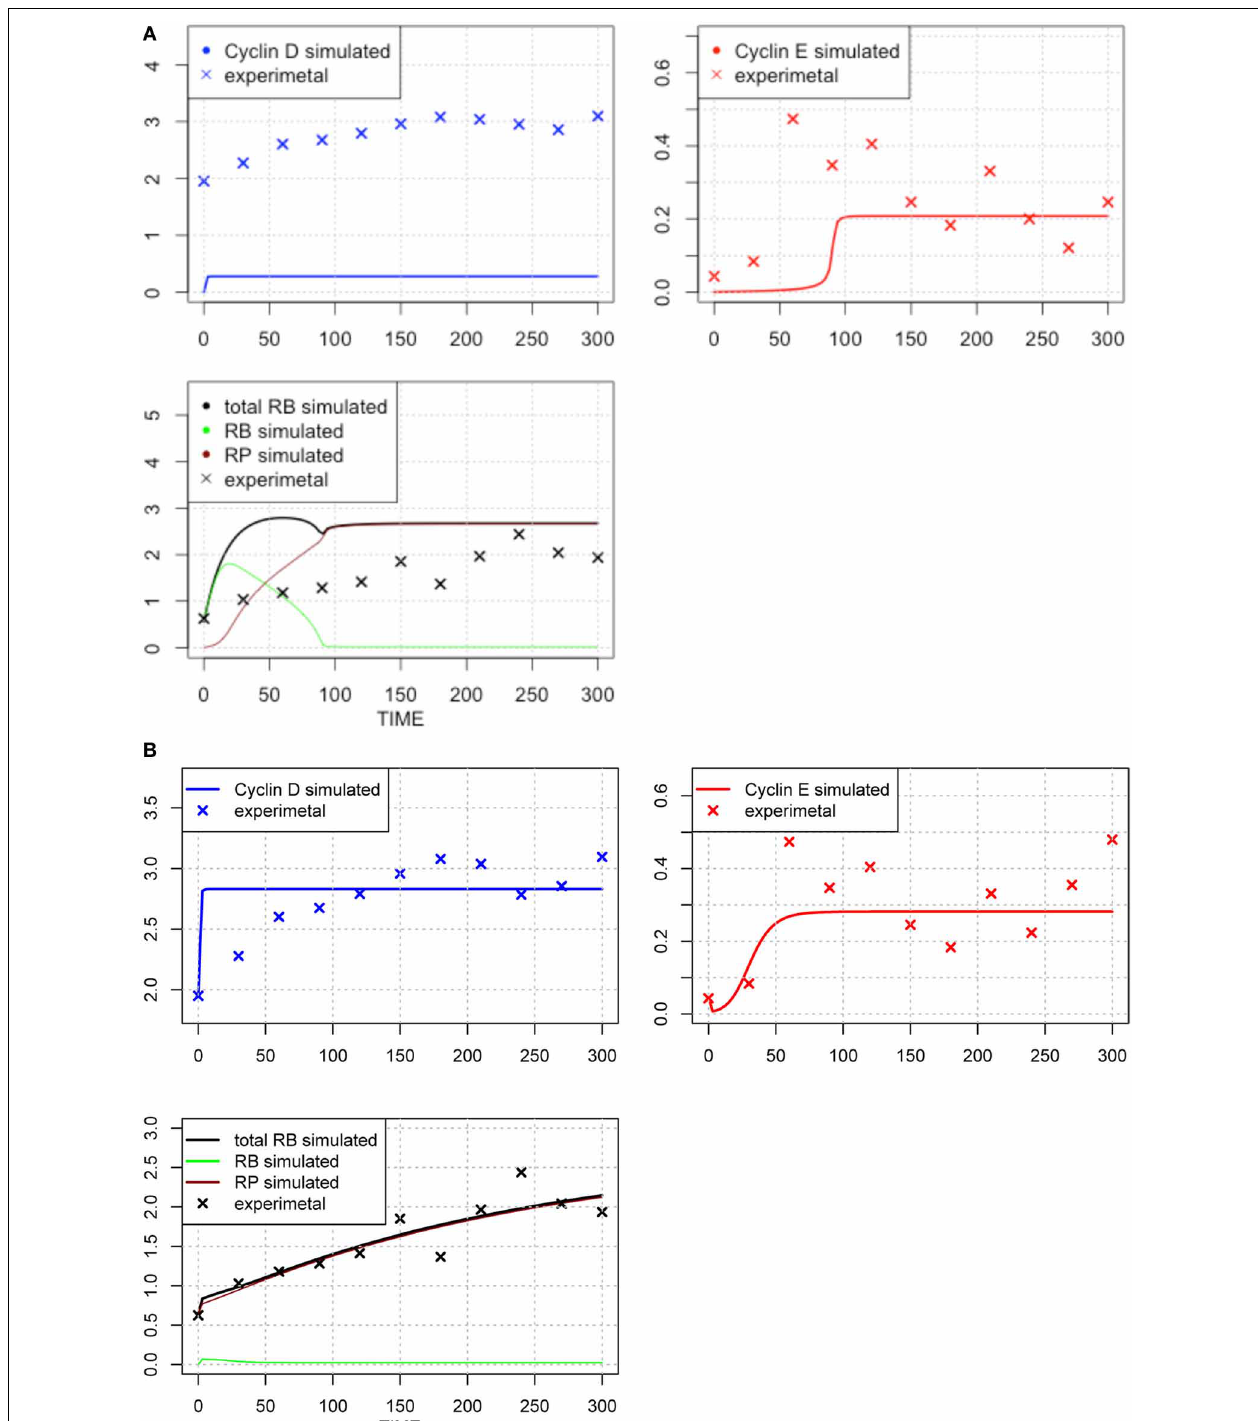
FIGURE 2 | Time-course of concentrations of proteins in the model. The x-axis indicates the Time [min], the y-axis indicates the concentration of the species [nM]. The upper left panel shows Cyclin D (line: simulation result, cross: experimental result), upper right panel shows Cyclin E (line: simulation result, cross: experimental result), lower panel shows phosphorylated (brown line), dephosphorylated (green line) and their sum (black line) of simulation data, with experimental result (black cross). The three species were fitted to